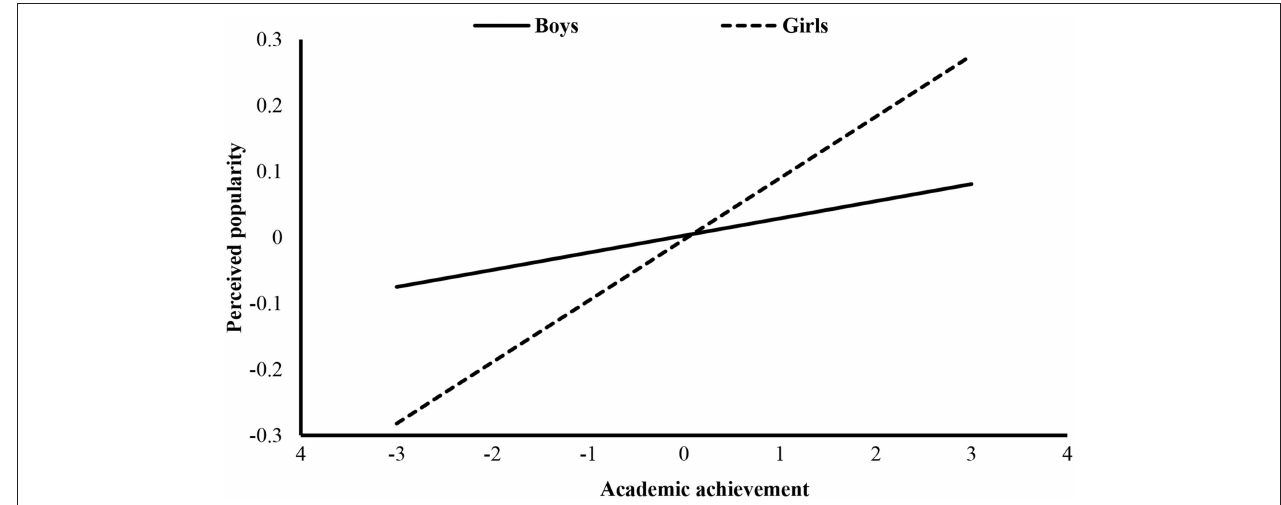
FIGURE 1 | Moderating effects of gender on relations between academic achievement and perceived